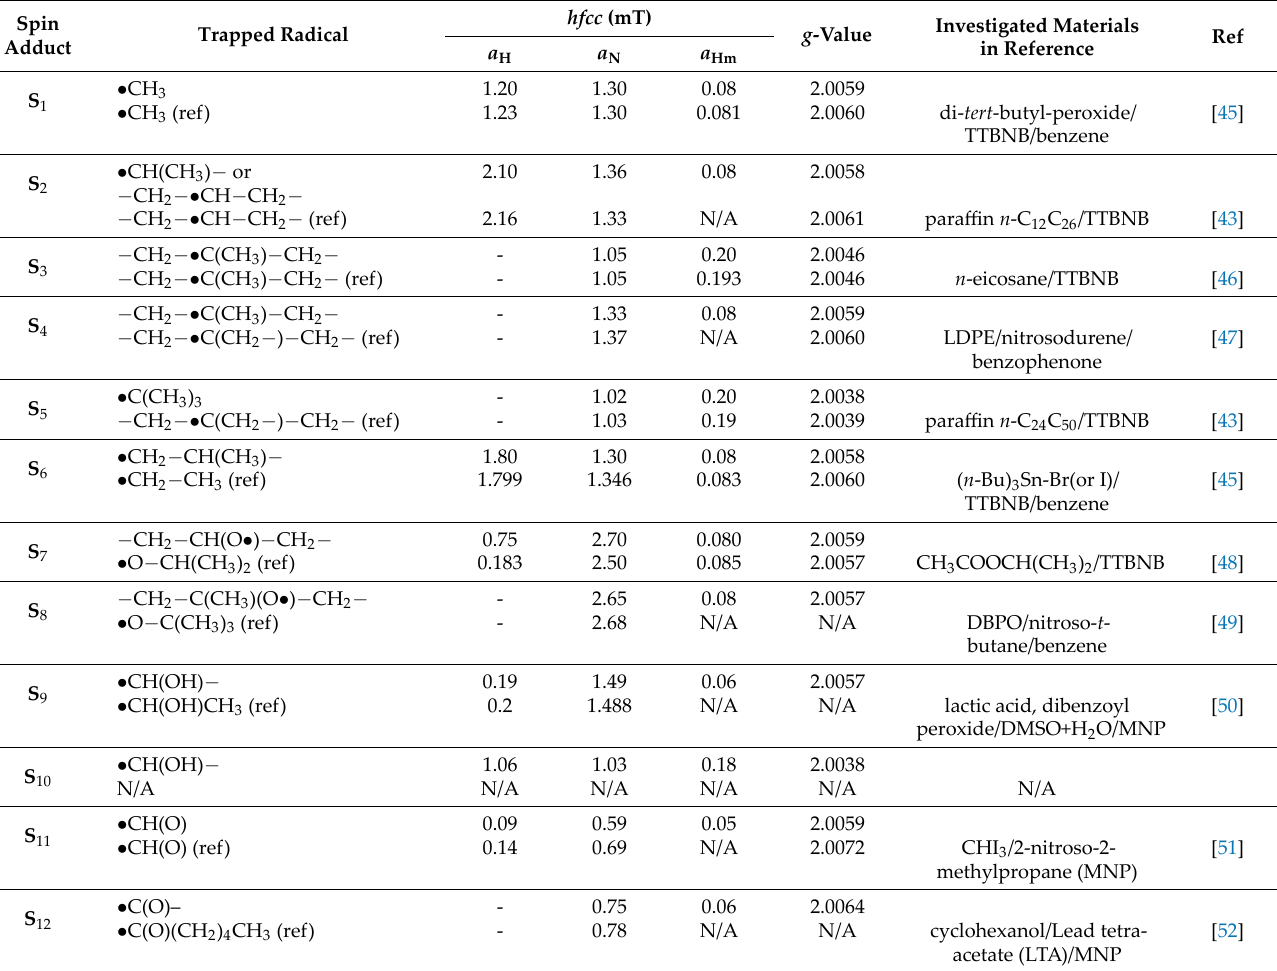
Table 5. Spectral parameters of the spin adducts S 1 – S 12 for PP/TTBNB heated from RT to 250 and the literature data used to assign